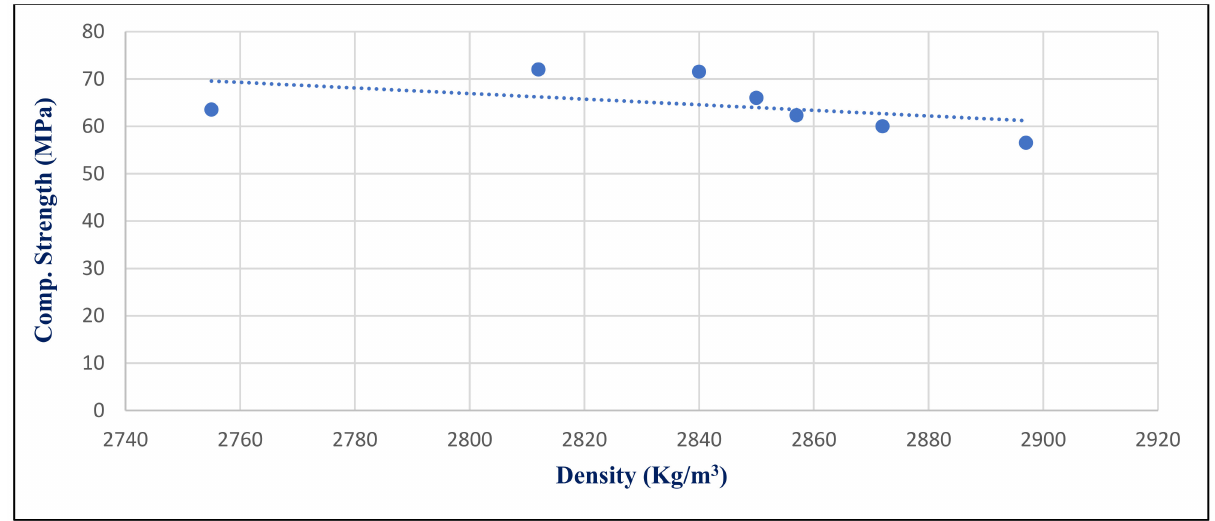
Figure 36. Correlation relation between density and compressive strength for group Z at 750 ◦ Cat day